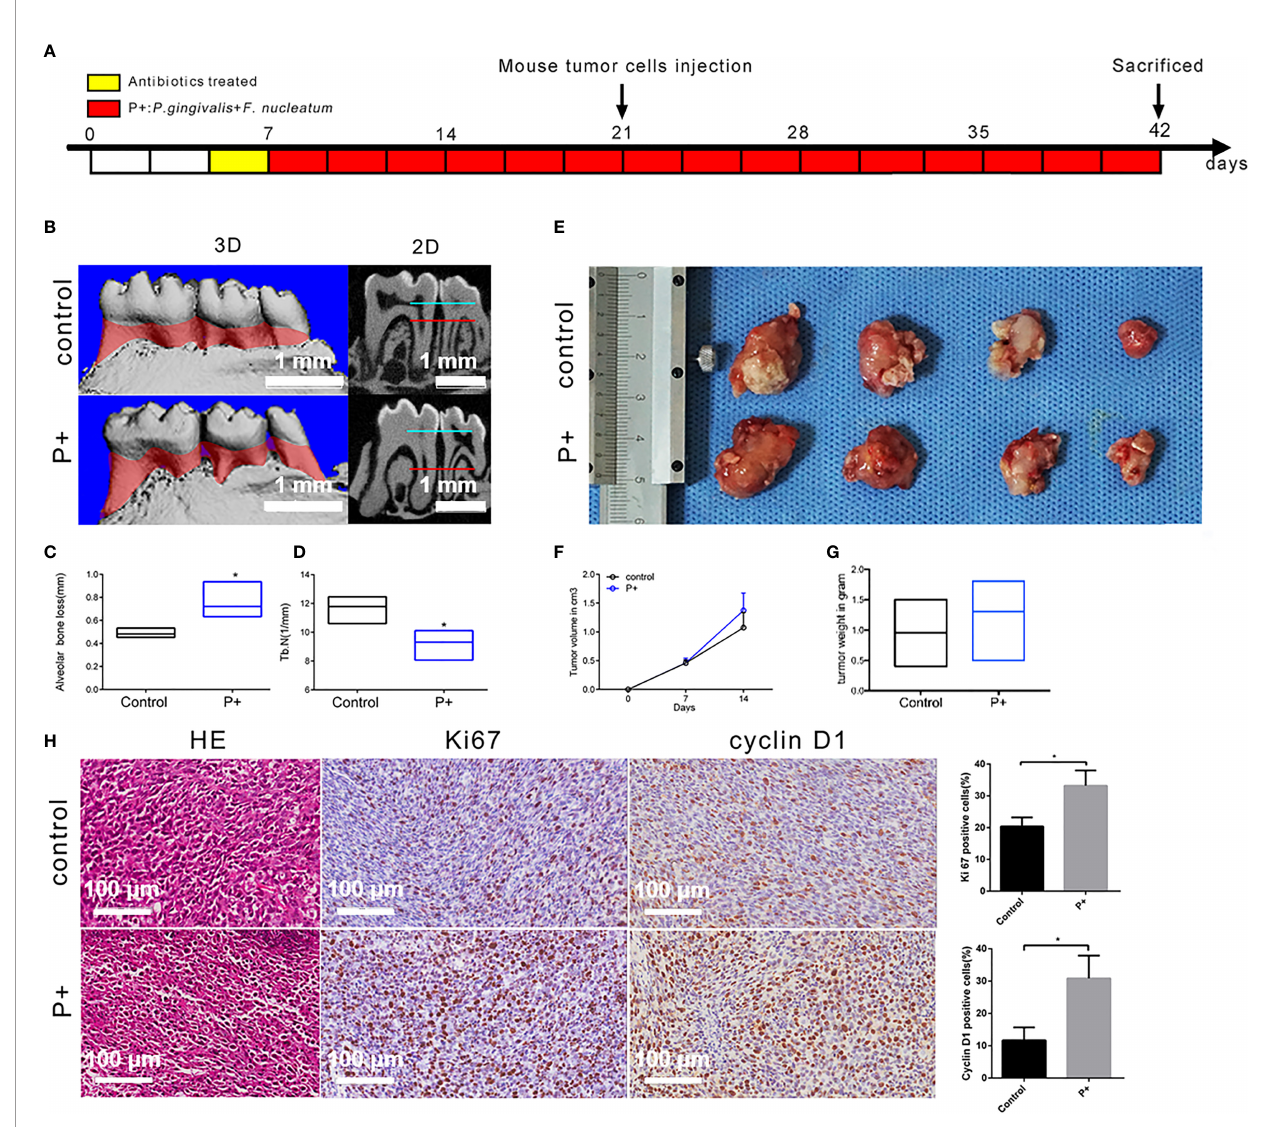
FIGURE 2 | Effect of periodontitis-associated bacteria on alveolar bone resorption and tumor histology in tumor-bearing mice. (A) Flowchart of the experimental design. (B) The microCT analysis. (C) Measurement of the alveolar bone resorption of mice. *p < 0.05. (D) Measurement of the number of trabecular bones (Tb. N) (1/mm) *p < 0.05. (E) The observation of tumor morphology. (F) Weekly measurement of the tumor volume. (G) Measurement of the tumor mass. (H) H&E staining and representative immunohistochemistry (IHC) results for Ki67 and cyclin D1, and the percentage of Ki67-positive and cyclin D1-positive cells in the control and P+ groups. *p <